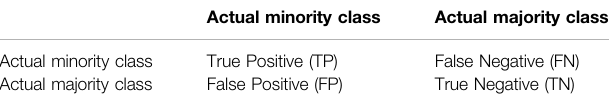
TABLE 4 | The confusion matrix